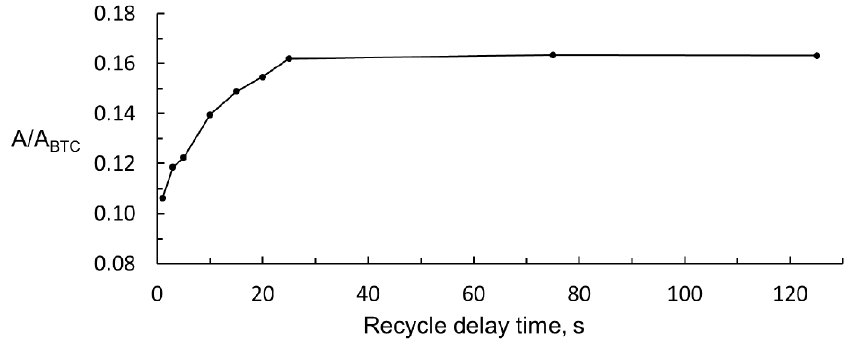
Figure 4. Change in acrolein relative signal with recycle delay time.